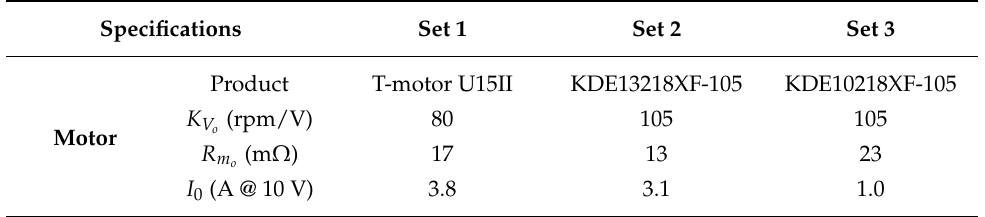
Table 4. Sample sets for model